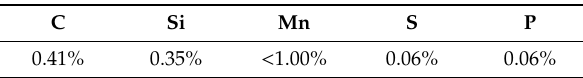
Table 1. Composition of EN 8 (wt.%).